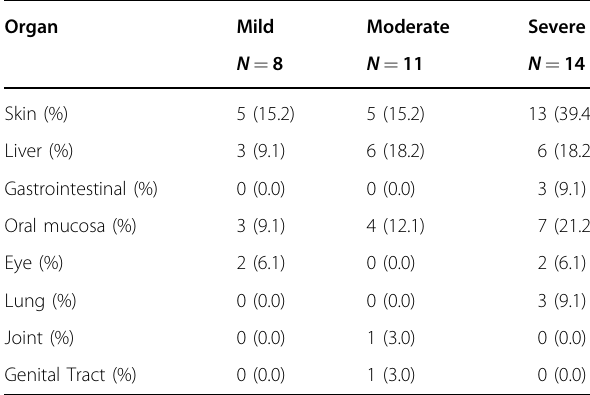
Table 2 Clinical manifestations of cGVHD.